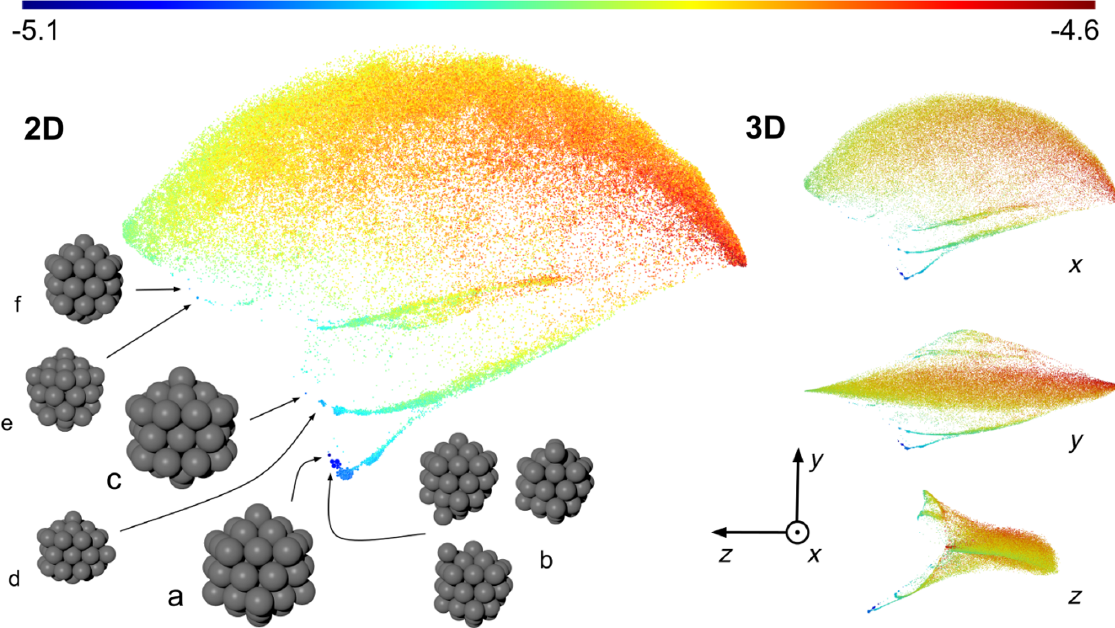
FIG. 10. 2D and 3D SHEAP maps for 49813 minima on the LJ 55 PES, generated with RSS, described by sorted lists of all pairwise distances. Projections use a perplexity of 30, with a minimum sphere radius 0.01. The circles representing each structure are colored according to energy per atom in Lennard-Jones units; see the color bar at the top of the figure. Basin volumes are represented by the area of each circle. (a) – (f) label selected structures in the landscape: (a) I h , global minimum; (b) C s , all have one surface atom relocated relative to global minimum; (c) D 5 h , lowest-energy structure in funnel branching off from that to global minimum; (d) C 1 , one atom relocated relative to D 5 h ; (e) C 5 v and (f) C 5 , high-symmetry structures outside the main (sub)funnels to I h and D 5 h . Each viewpoint of 3D map looks down one of the axes displayed, as labeled; the axes have no other physical